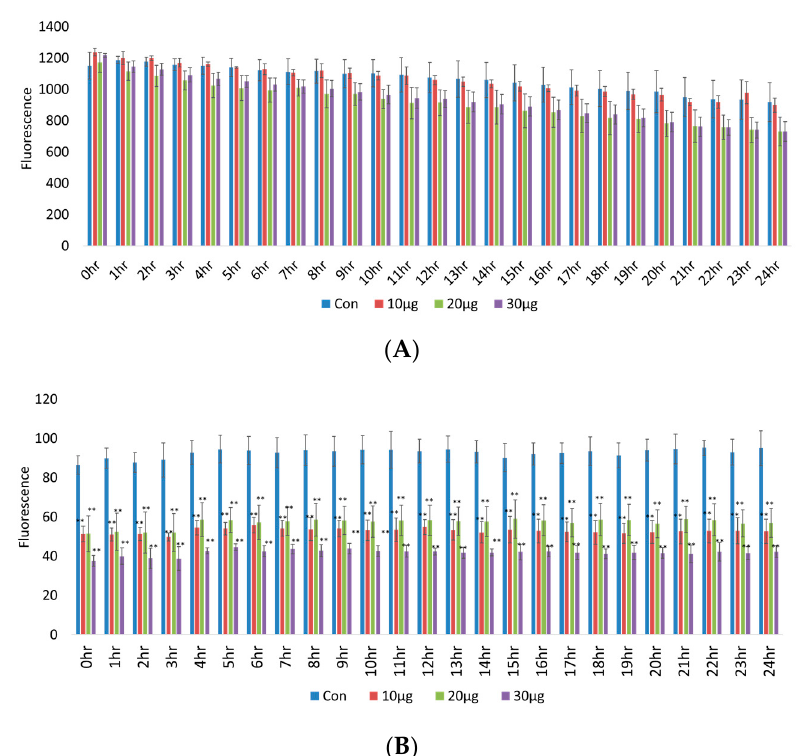
Figure 3. RAW264.7 macrophage intracellular Ca 2+ concentration and mitochondria membrane potential: ( A ) There was no significant change ( p > 0.05) under pretreatment with various concentrations of acetyl-xylogalactan following incubation at 41 °C. ( B ) Mitochondrial membrane potential recovery was lower in the treatment groups than in the control group ( p < 0.01) (Treatment was presented as 10 μ g means the 10 μ g acetyl-xylogalactan/mL (culture medium); 20 μ g means the 20 μ g acetyl-xylogalactan/mL (culture medium); 30 μ g means the 30 μ g acetyl-xylogalactan/mL (culture medium)) ( p < 0.05 was marked as *, p < 0.01 was marked as **).